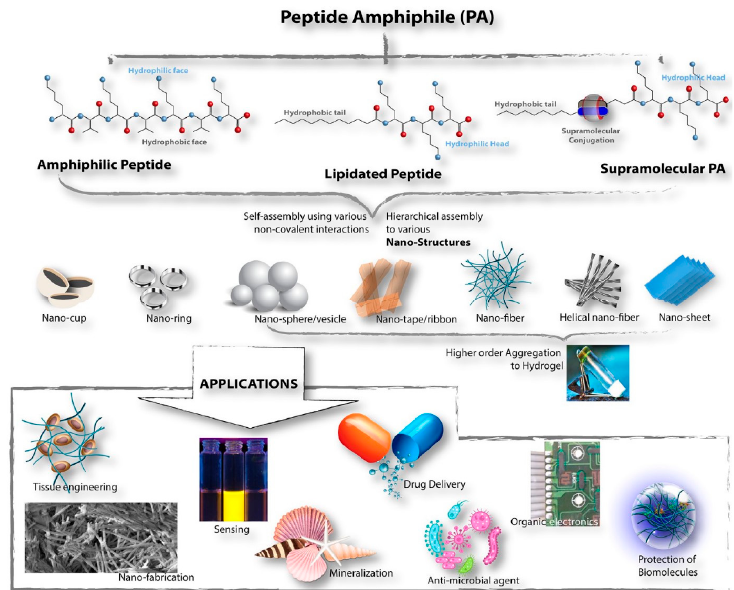
Figure 10. Schematic overview of the peptide amphiphile (PA) classification, different self-assembled nanostructures formed, and PA applications [134].